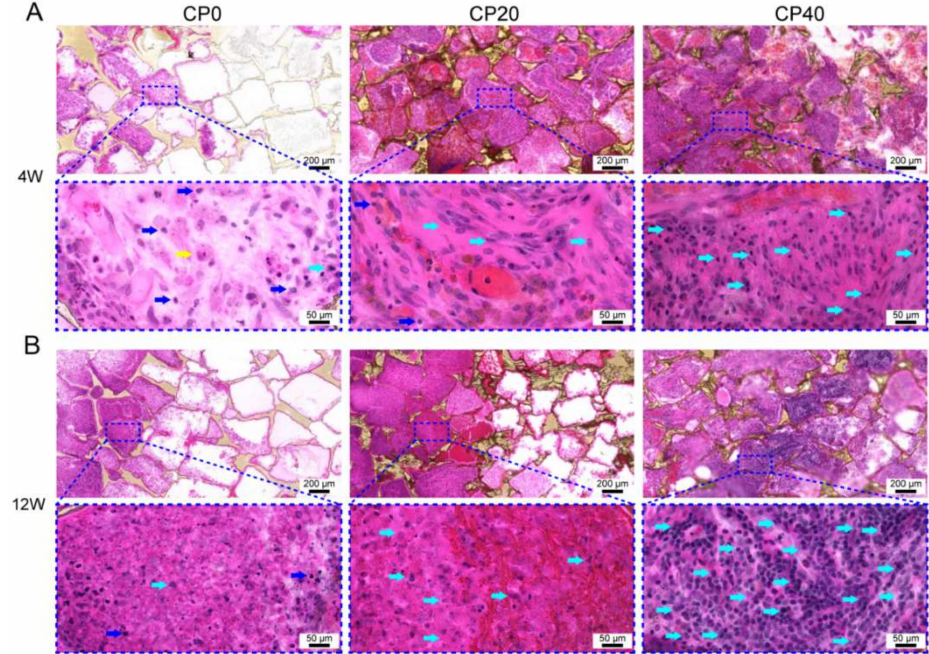
Figure 8. H&E staining of implant scaffolds at 4 weeks ( A ) and 12 weeks ( B ). Inflammatory cells (dark-blue arrows), giant cells (yellow arrow), and bone marrow-derived mesenchymal cells (light-blue